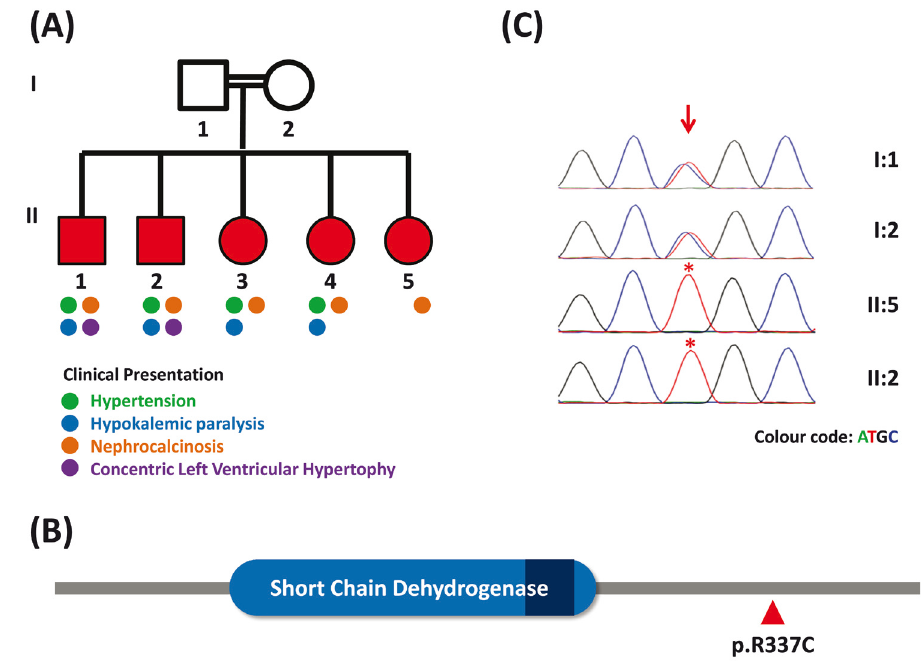
Figure 1. ( A ) Family pedigree marked with progressive phenotypes. ( B ) Secondary structure of HSD11B2 marked with major domains and the p.R337C amino acid position. ( C ) Capillary sequencing chromatogram representation of p.R337C variation in the family; arrow and asterisks marks depict the variation loci and affected individuals